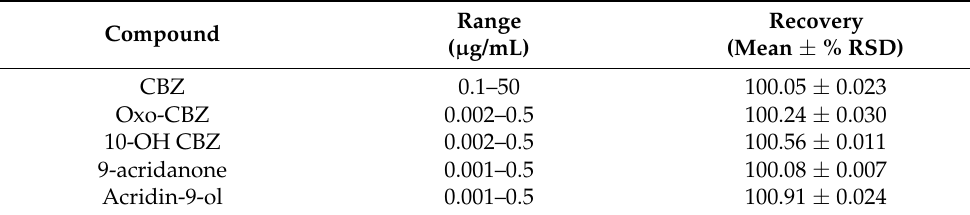
Table 6. Accuracy values of CBZ and the detected degradation intermediates in water.